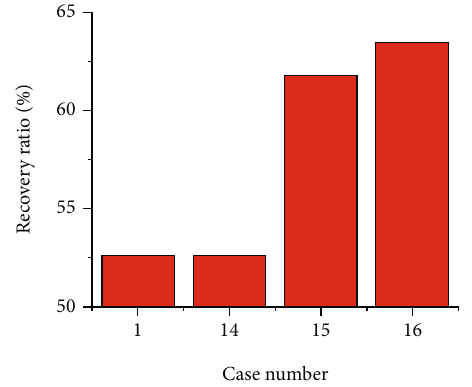
Figure 14: Comparison of the recovery e ffi ciency before and after adjustment of the injection production